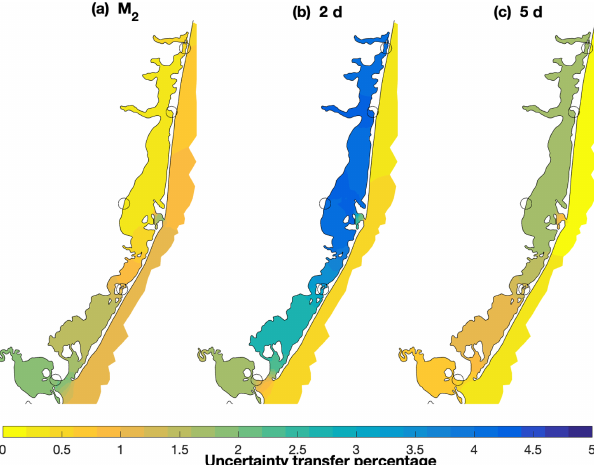
Figure 11. Uncertainty in transfer estimate based on ADCIRC tidal database for three frequencies: (a) M 2 semidiurnal tide, (b) 2d fluc- tuation in the storm band, and (c) 5d fluctuation in the storm